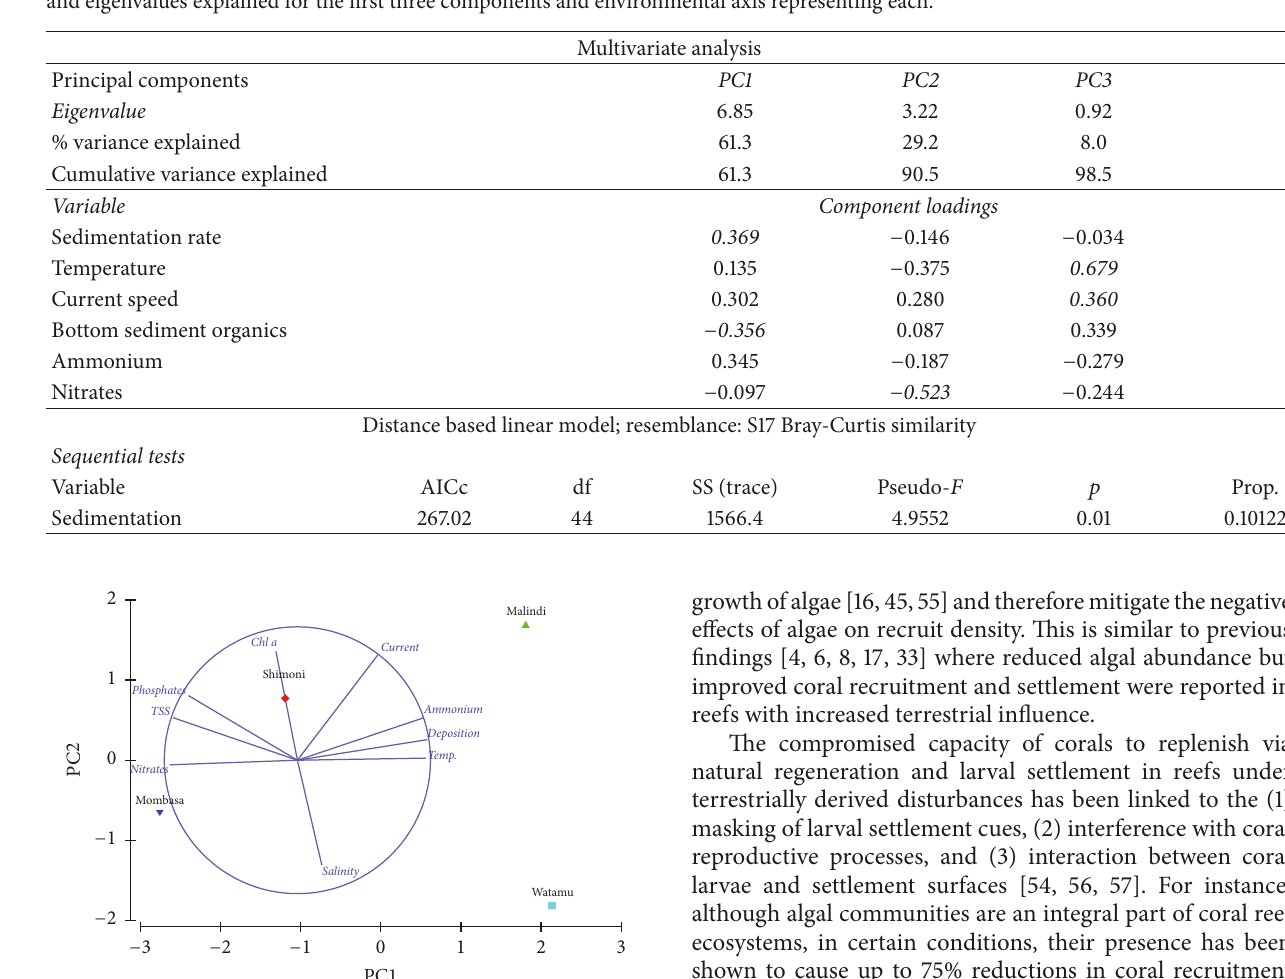
Table 6: Principal component analysis (PCA): summary of environmental measurements and statistics and PCA results. Percent variance and eigenvalues explained for the first three components and environmental axis representing each.